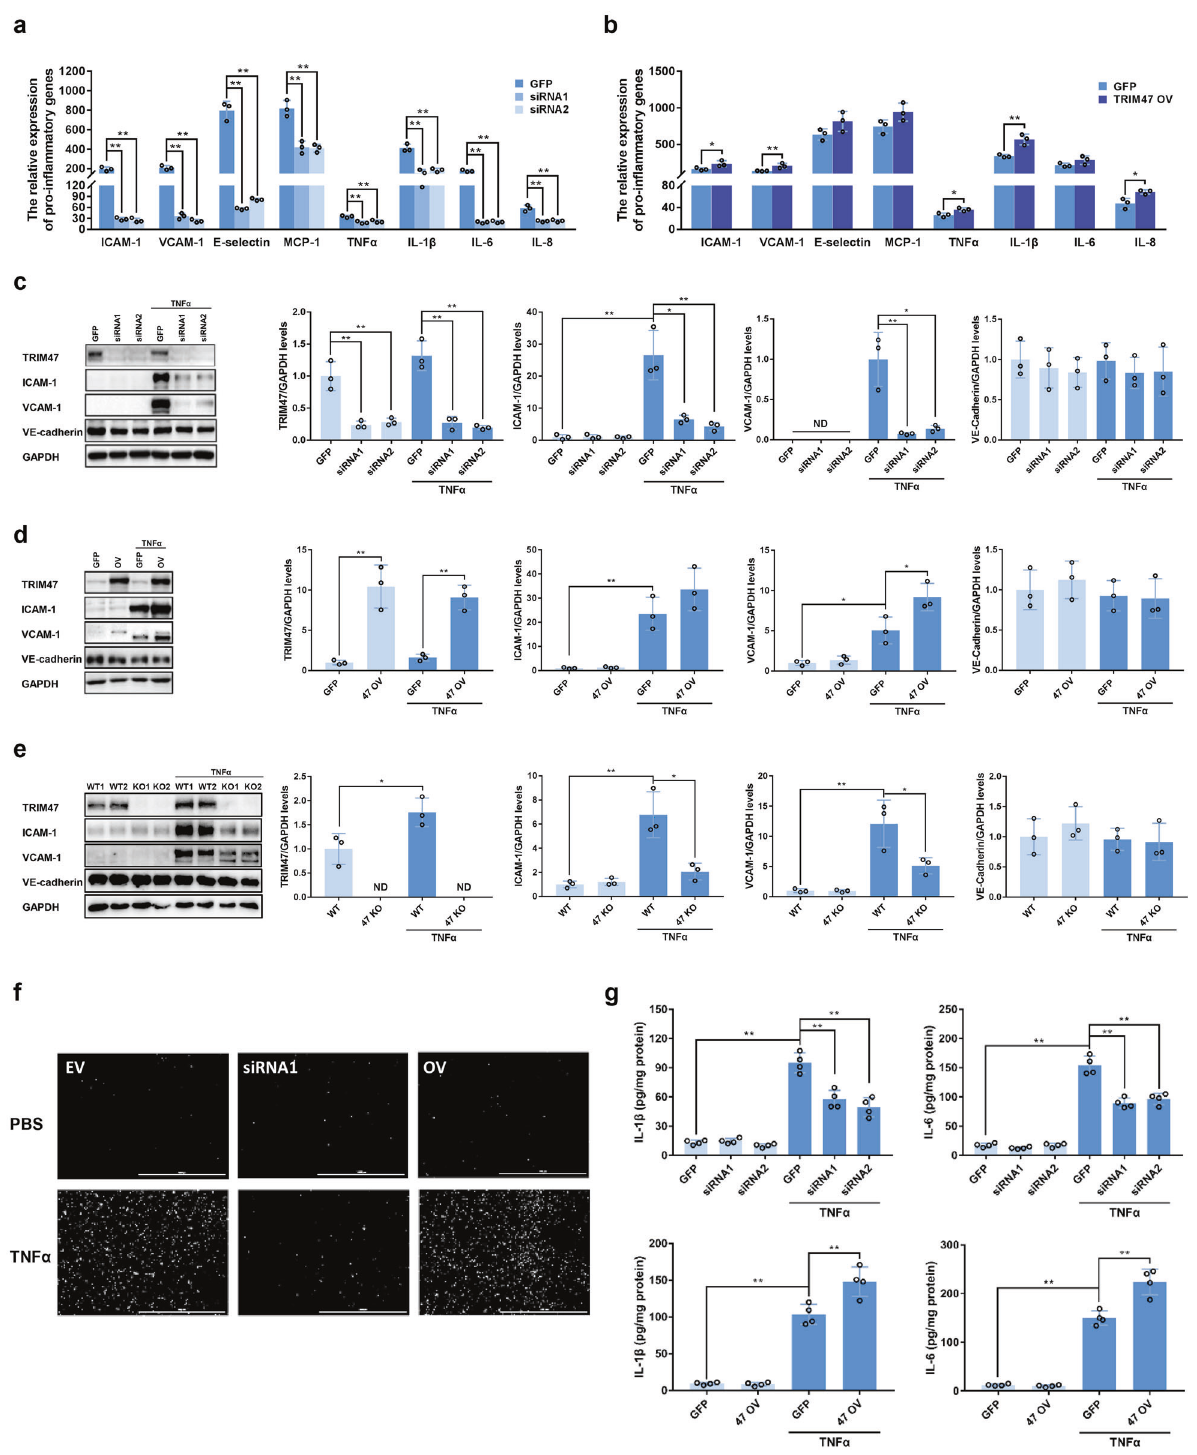
Fig. 5 TRIM47 promotes in fl ammatory response in endothelial cells. The mRNA expression of multiple adhesion molecules and pro- in fl ammatory cytokines was detected by real-time PCR in ( a ) TRIM47 siRNA- and ( b ) overexpression vector-transfected HUVECs ( n = 3, one-way ANOVA, * P < 0.05, ** P < 0.01). Representative images of the immunoblots of TIRM47, ICAM-1, VCAM-1, VE-cadherin, and GAPDH after TNF α stimulation detected by western blot and the relative quantitation of the protein levels in ( c ) TRIM47 knockdown HUVECs, ( d ) TRIM47 overexpression HUVECs, and ( e ) the pulmonary microvascular endothelial cells from wild-type (WT) and TRIM47 Knockout (KO) mice. ND not detected. ( n = 3, one-way ANOVA, * P < 0.05, ** P < 0.01). f Representative images of the adhesion of THP-1 to siRNA- and overexpression vector-transfected HUVECs were observed under a fl uorescence microscope ( n = 3). Scale bar, 1000 μ m. g The levels of IL-1 β and IL-6 in siRNA- and overexpression vector-transfected cells were measured by ELISA ( n = 4, one-way ANOVA, ** P < 0.01)